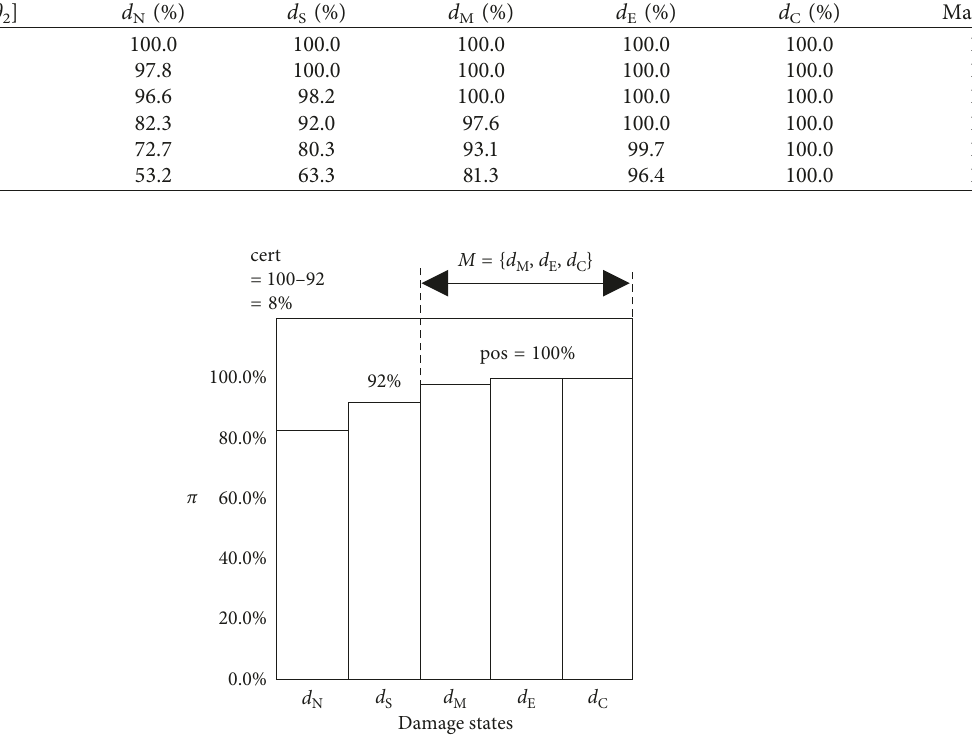
M , d E , d C } for the PGA (g) interval of